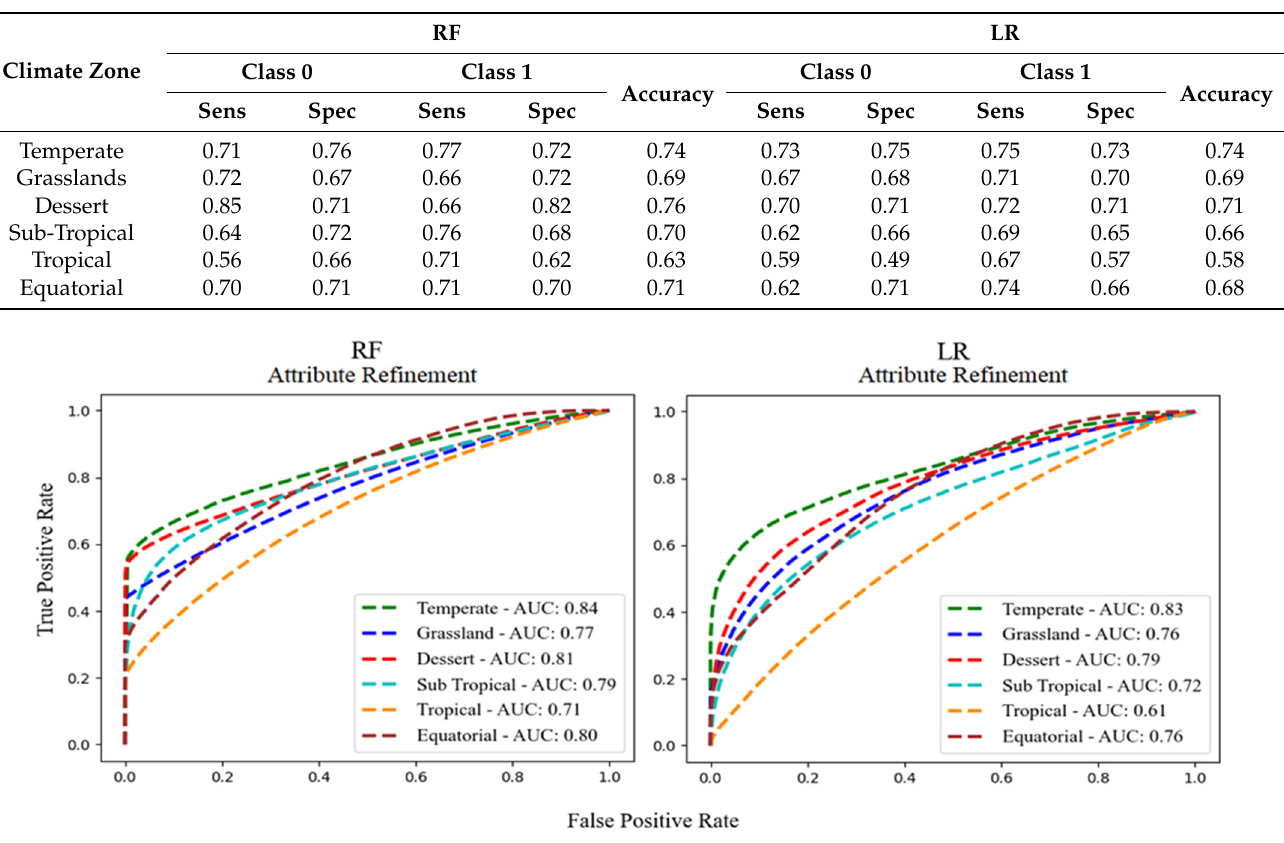
Table 1. Sensitivity (Sens), specificity (Spec) and classification accuracy of RF and LR models with attribute refinement method (outliers removed from temperature and relative humidity predictors in class 0 (no-fire class)) across all climate zones in Australia. Class 0 is no-fire and class 1 is fire size class.